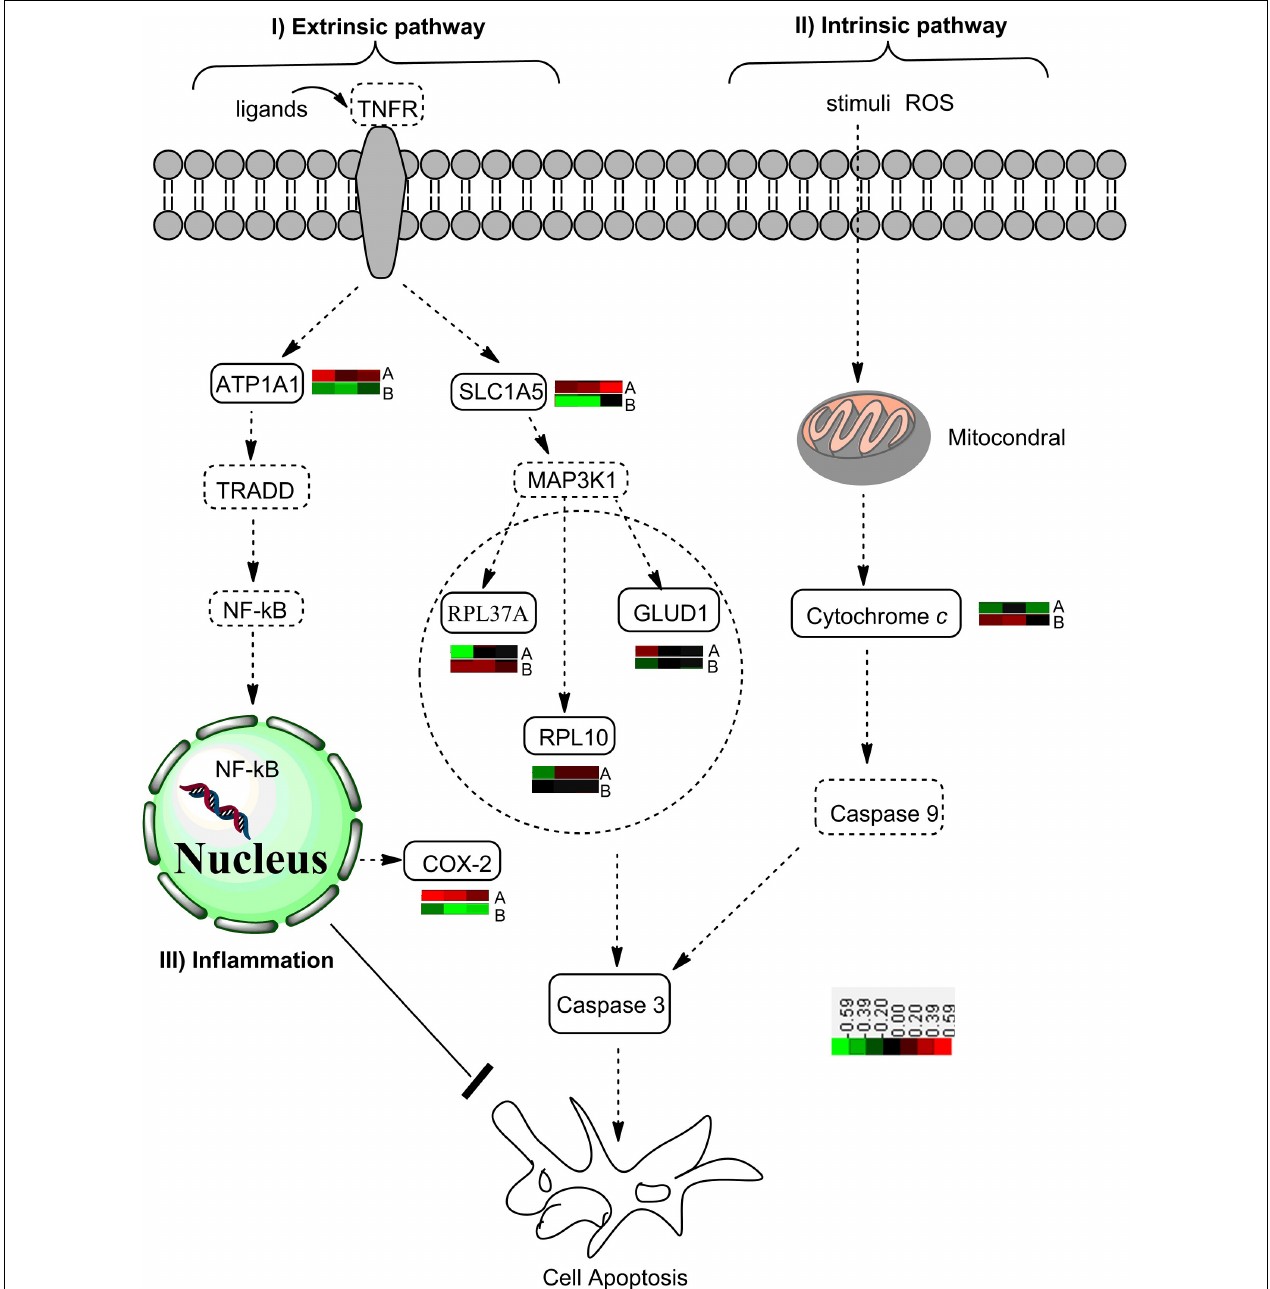
FIGURE 7 | A diagram showing the effects of citreamicin ε A and B on the apoptotic pathway. I The extrinsic pathway includes tumor necrosis factor (TNF) and TNF family ligand receptor. The activation of downstream signaling and the formation of the death-inducing signaling complex are due to the binding of ligands to their respective receptors. Nuclear transcription factor κ B is active for entry into the nucleus and rapid transcription of antiapoptotic genes. The failure to activate NF- κ B promotes ASK1/MAPKKK activation, which triggers cell apoptosis. ASK1, apoptosis, signal-regulating kinase 1; MAPKKK, mitogen-activated protein (MAP) kinase; NF- κ B, nuclear transcription factor κ B. II Intrinsic pathway is triggered by various apoptotic stimuli (e.g., ROS), which mediate the permeabilization of the mitochondrial outer membrane and the release of proapoptotic proteins such as cytochrome c. Within the cytosol, cytochrome c forms the apoptosome complex to active procaspase-9. The activation of caspase-3 catalyzed by caspase-9 executes the final steps of apoptosis. III The increased NF- κ B activity is linked to increased COX-2 expression and synergistically activates transcription of the inflammatory cytokines. The overexpression of COX-2 inhibits apoptosis in epithelial cell models. COX-2, cyclooxygenase 2. : proteins enriched by PPI Spider; : proteins detected by MSMS. The color bar indicates the protein expression level. Red: up-regulated, black: no change; green: down-regulated.